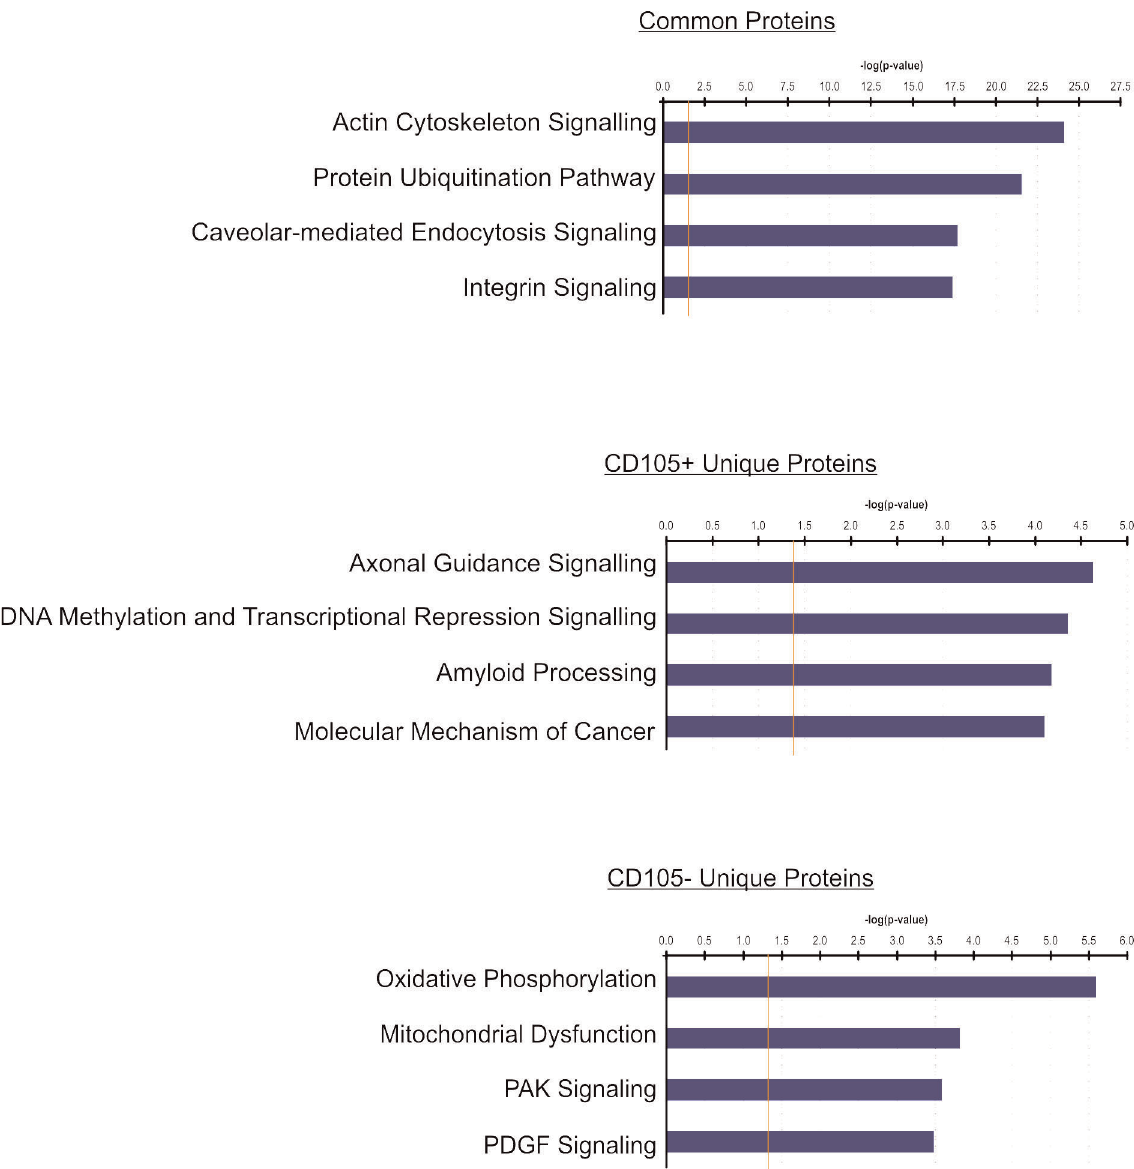
Figure 2. Proteins uniquely expressed in multipotent and non-multipotent stroma are involved in distinct canonical pathways. Lists of proteins that were either common or unique to CD105 + and CD105 2 stroma were analyzed using Ingenuity Pathway Analysis software. The orange line signifies the cut-off P value used to assess the significance of each pathway. The top 4 canonical pathways identified in each group are reported.